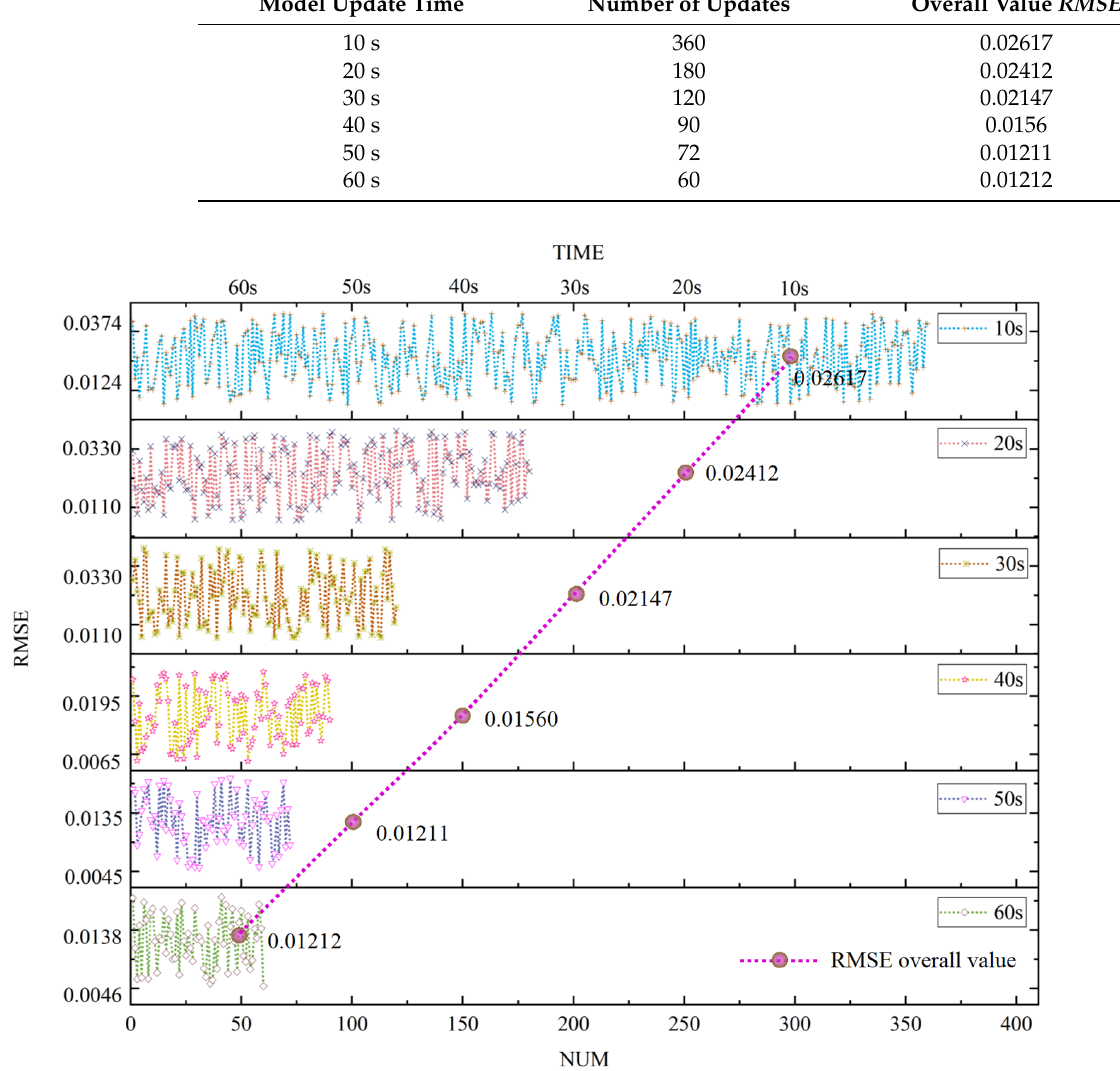
Figure 14. Comparison of prediction results of different models. 0